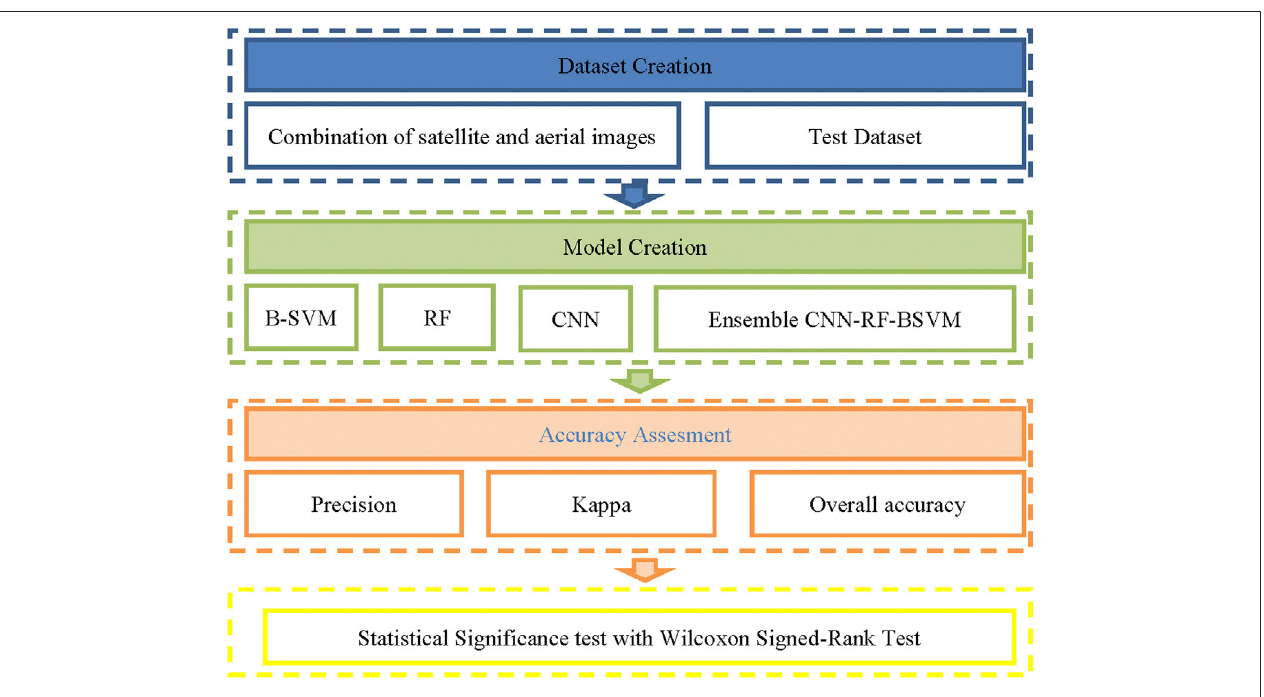
FIGURE 3 | Flowchart of the used methodology in the